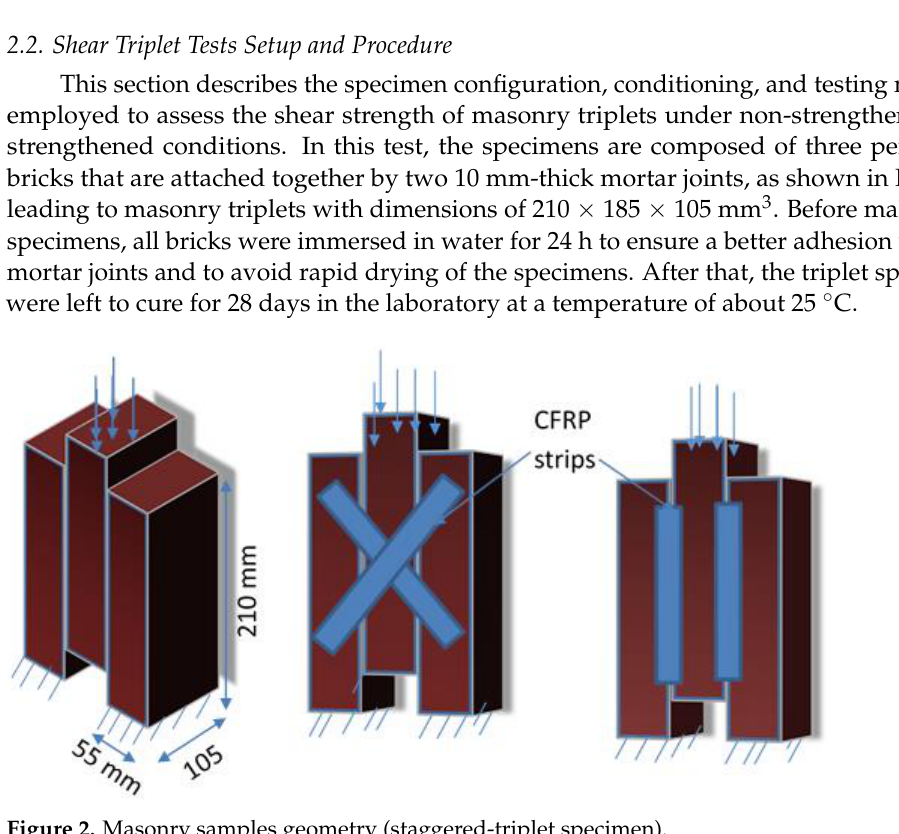
Figure 2. Masonry samples geometry (staggered-triplet